Question: Provide a one-line summary of what is displayed.
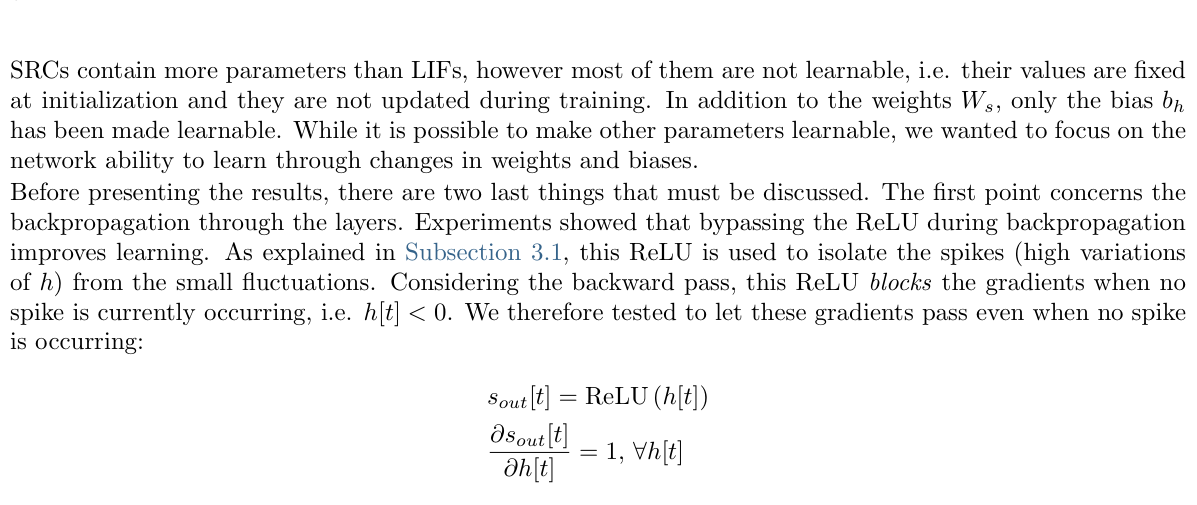
Answer: shows the evolution of the accuracy and cross-entropy of two SRC networks composed of 5 layers, one trained with the ReLU bypass, the other without. For each network we have trained 5 models. Except the bypass of the ReLU, all the other parameters are the same. When the gradients are back-propagated through the ReLU, the models do not manage to learn, while when the ReLU is skipped, learning is achieved, fast and leads to a good performance. We have therefore decided to use this trick for all the experiments. Although, note that the ReLU is still used during forward passes, to ensure that information is transmitted between neurons only when spikes occur. The second point concerns the backpropagation through time. A SRC neuron has three states: i, h and hs. This means that gradients can be backpropagated through time via three different paths. However, we found out empirically that preventing the gradients from flowing though the recurrent connections of h and hs improves learn